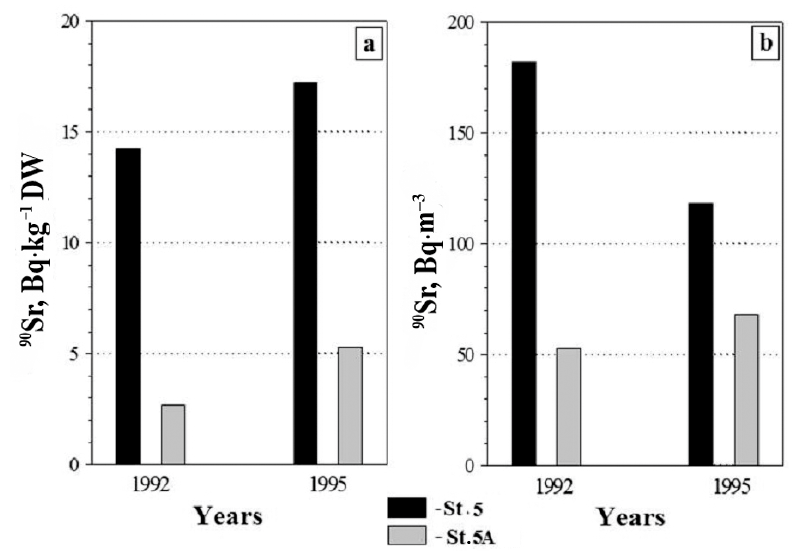
Figure 5. 90 Sr concentrations in bottom sediments ( a ) and water ( b ) of the NCC in July 1992 and 1995 in the irrigation (station 5) and outlet (station 5A) canals.